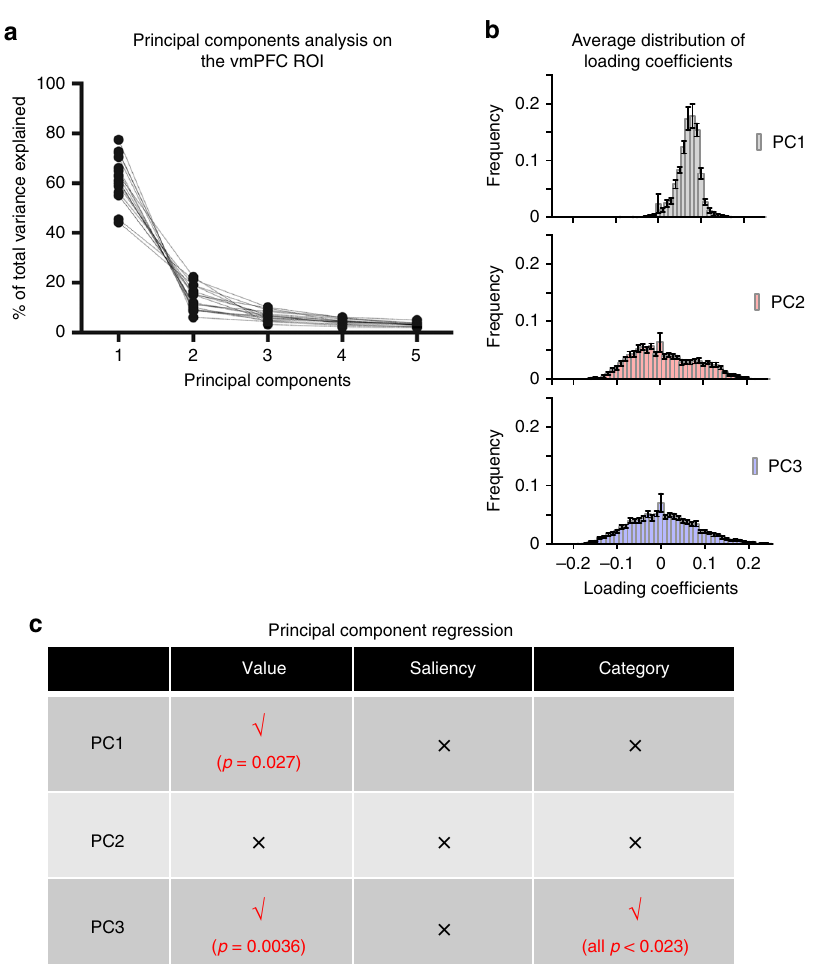
Fig. 7 Principal component analysis of ensemble patterns in vmPFC. a Percentages of total variance explained by the fi rst 5 PCs in each participant ( n = 17). Each dot is a data point from a participant, and data from the same participant are connected by dashed lines. b Average histograms of loading coef fi cients for the fi rst 3PCs. The frequency of loading coef fi cients falling under a particular bin was calculated separately for each participant. The mean and the SEM of frequencies in this bin were then obtained. This was repeated for all bins, spanning the entire range of loading coef fi cients. The mean frequencies in each bin are plotted here in the form of a histogram with error bars representing SEMs. c Summary of results of mixed-effect linear regression of the fi rst 3 PCs on value, saliency, and